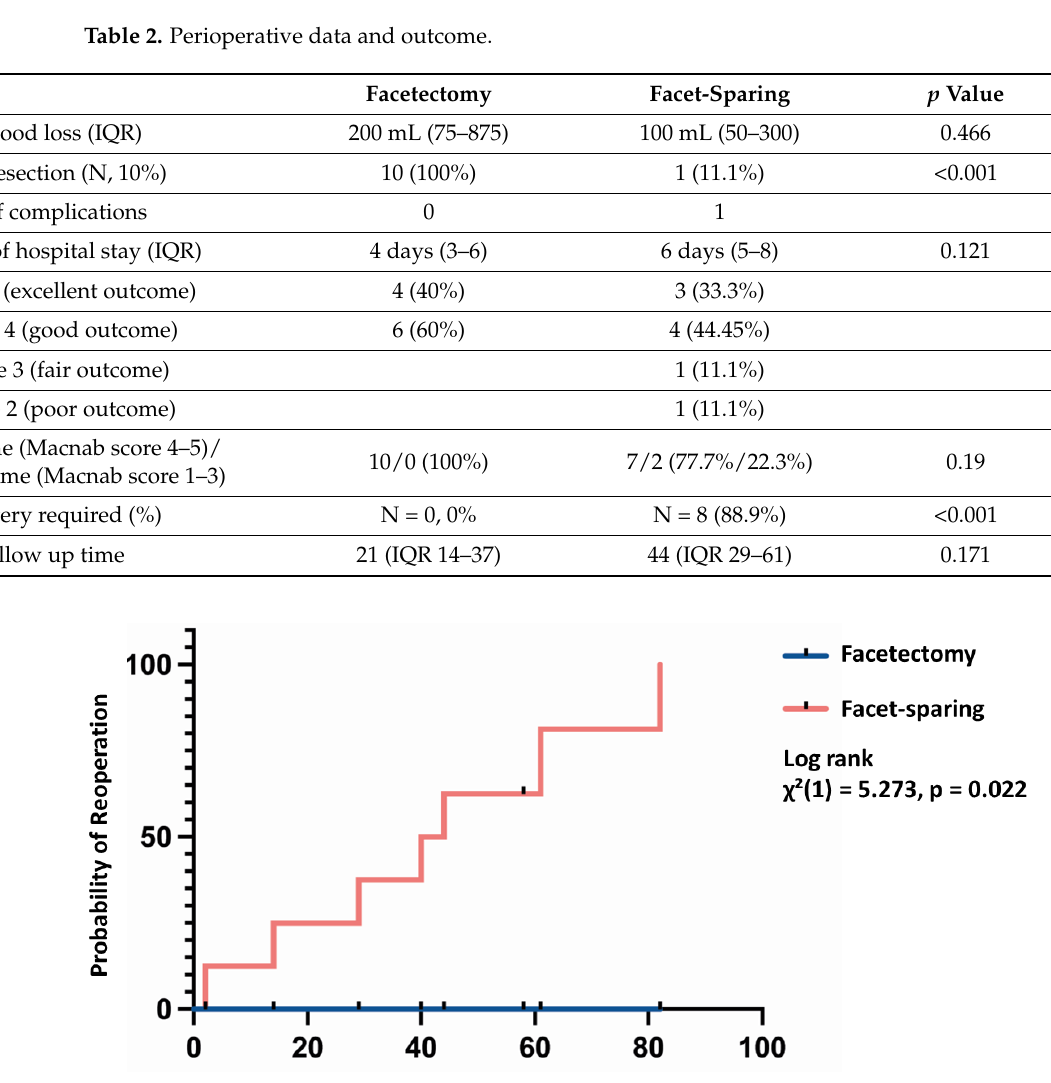
29 – 61). Log rank Meier-Kaplan analysis shows a higher risk of reoperation in the facet-sparing